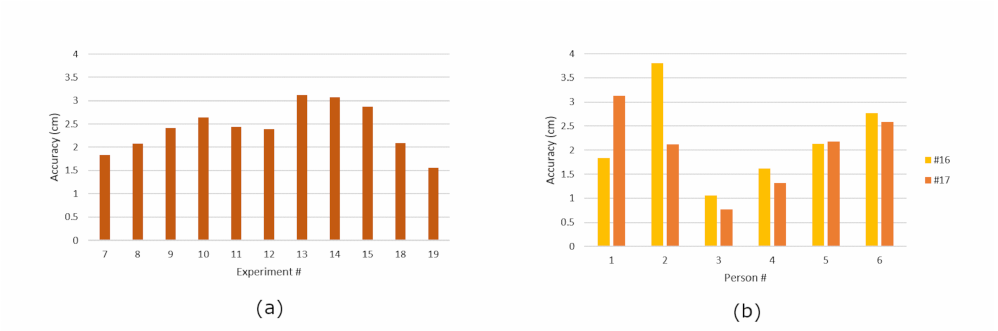
Figure 11. Accuracy graphs for all of the experiments performed on HoloLens 2: ( a ) HoloLens 2 accuracy results. ( b ) Experiments #16–#17